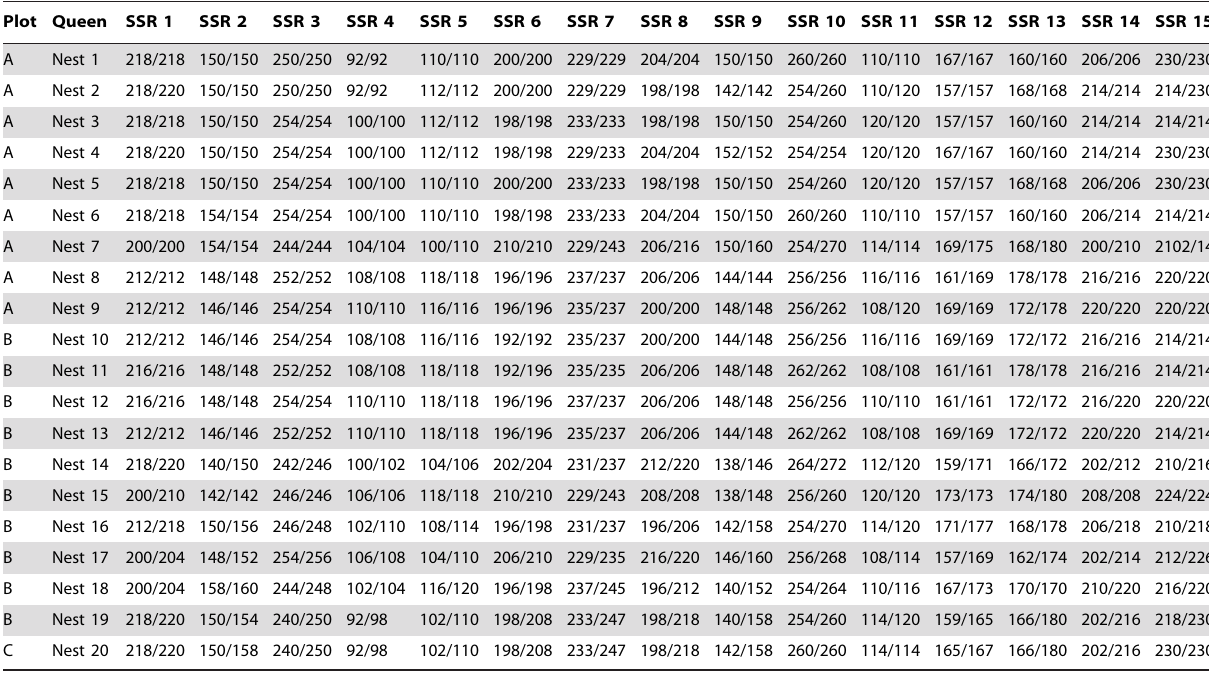
Plot Queen SSR 1